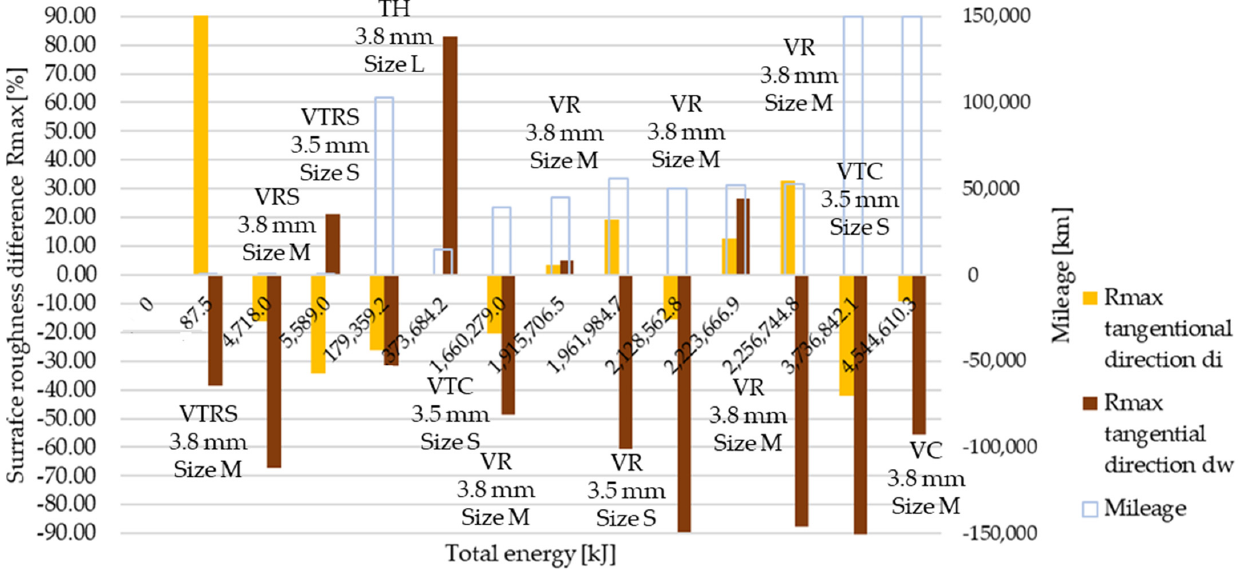
Figure 16. Deviation of Rmax surface roughness values from initial conditions, radial direction.